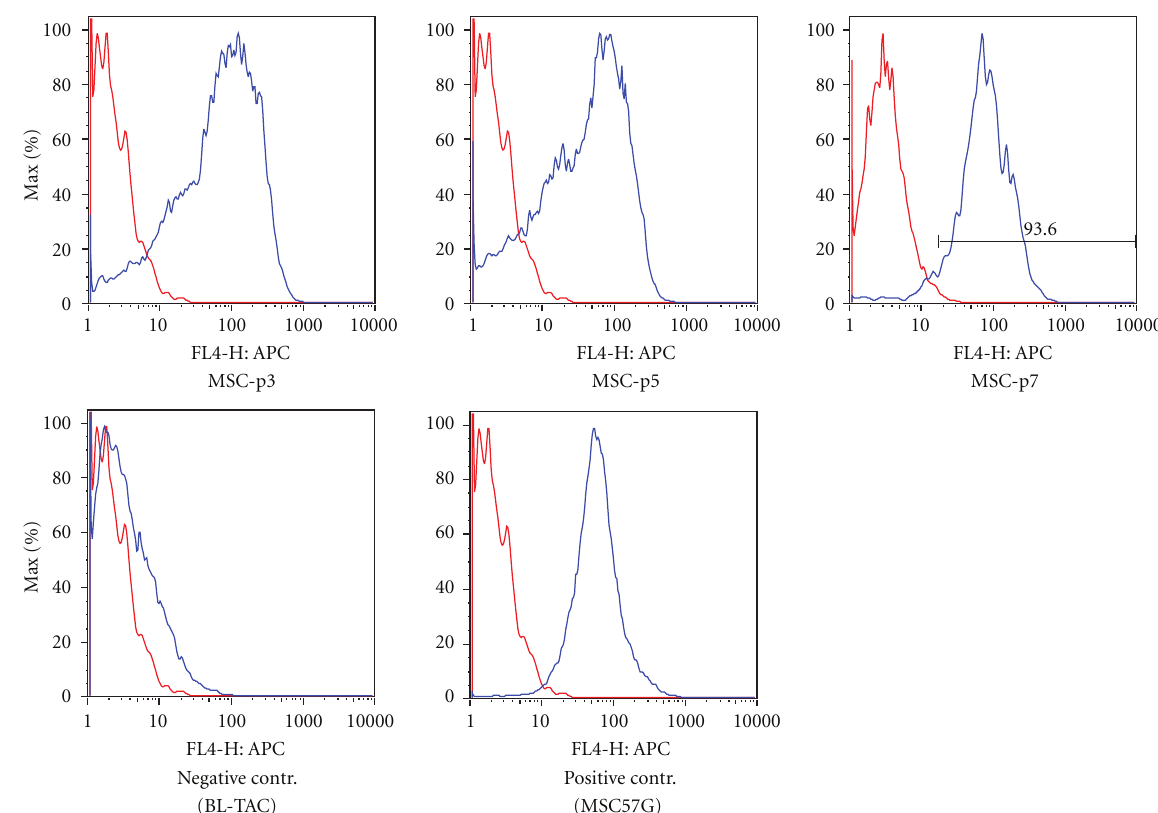
Figure 2: Flow cytometric characterization of MHC class I expression in bone marrow derived stem cells. The cells at passage 3 (MSC-p3), 5 (MSC-p5) or 7 (MSC-p7) were analyzed by FACS using monoclonal antibody to mouse MHC class I. Mouse melanoma derived cells (BL-TAC) and mouse fibrosarcoma derived cells (MSC57G) were used as negative and positive controls,